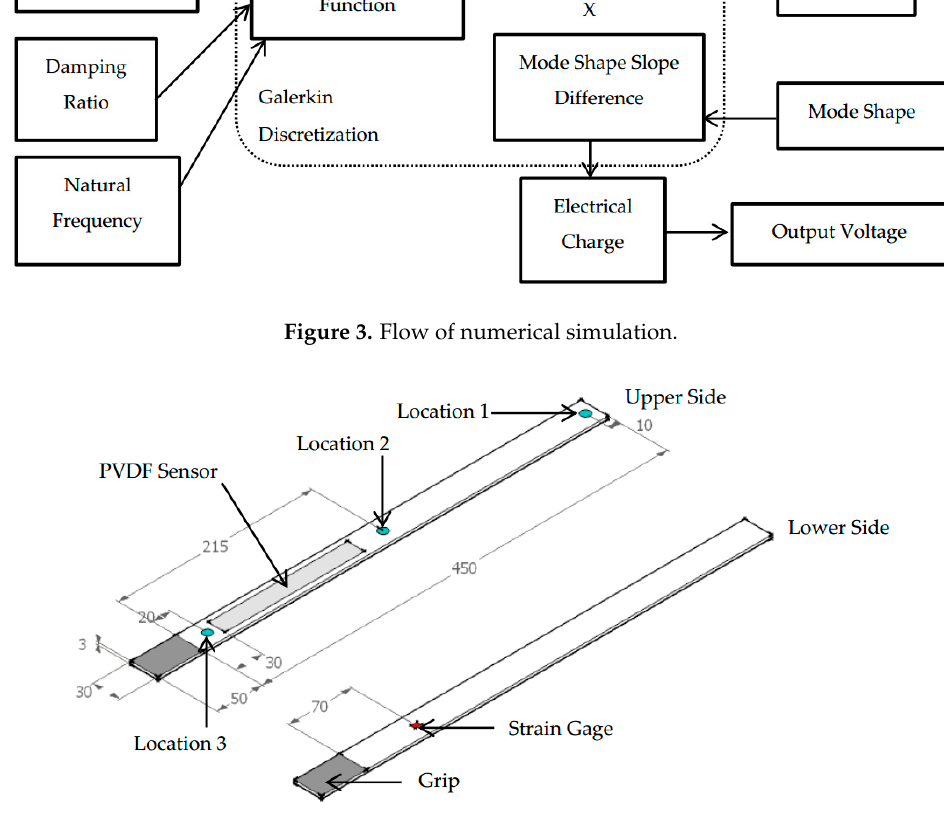
Figure 4. Configuration of cantilever beam with attached sensor and impact locations (Unit: mm).